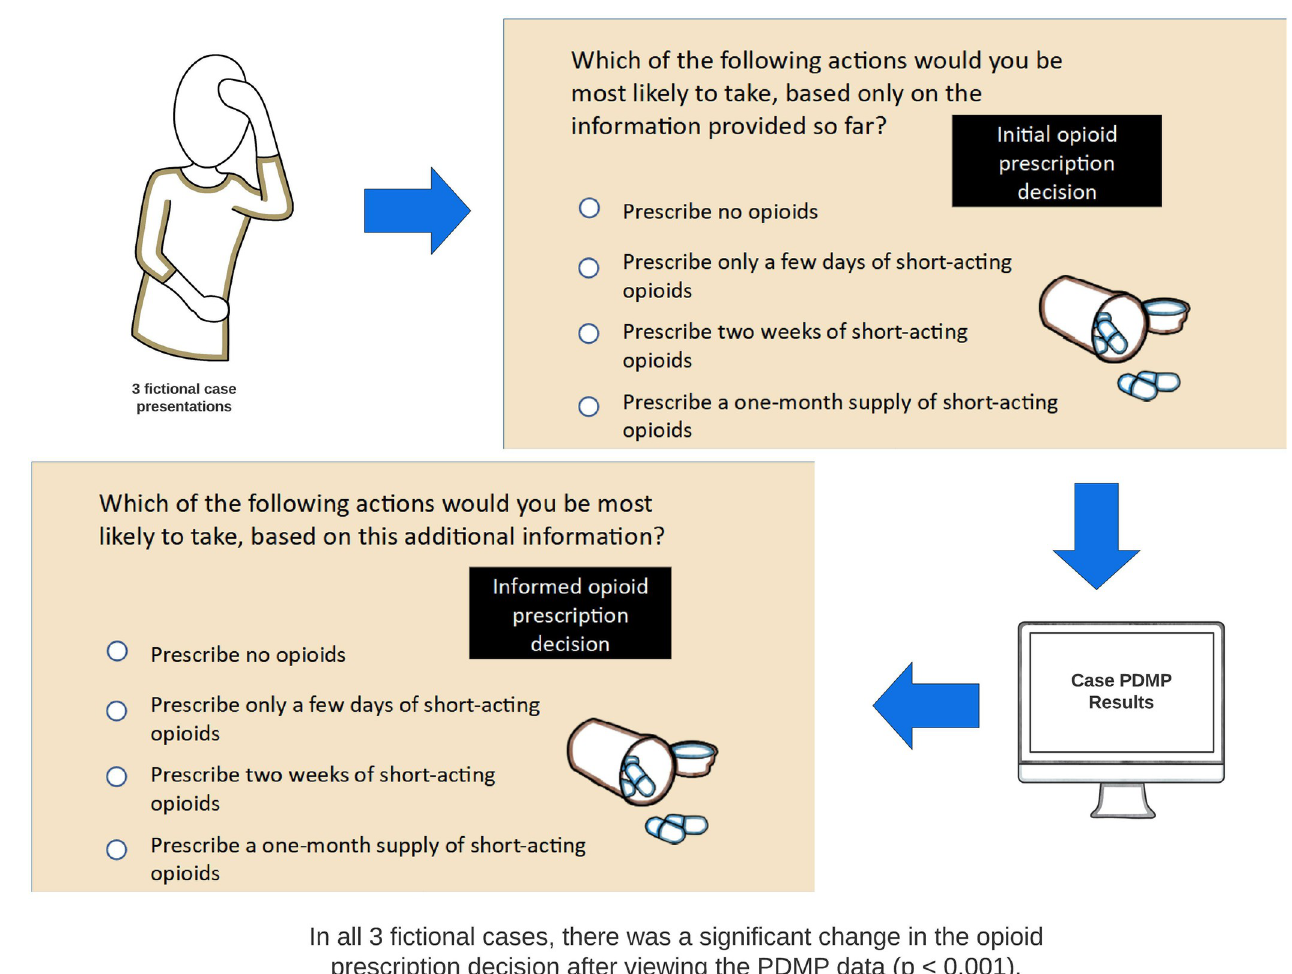
Fig 4. Training module case flow and changes in opioid prescription decisions based on PDMP data.